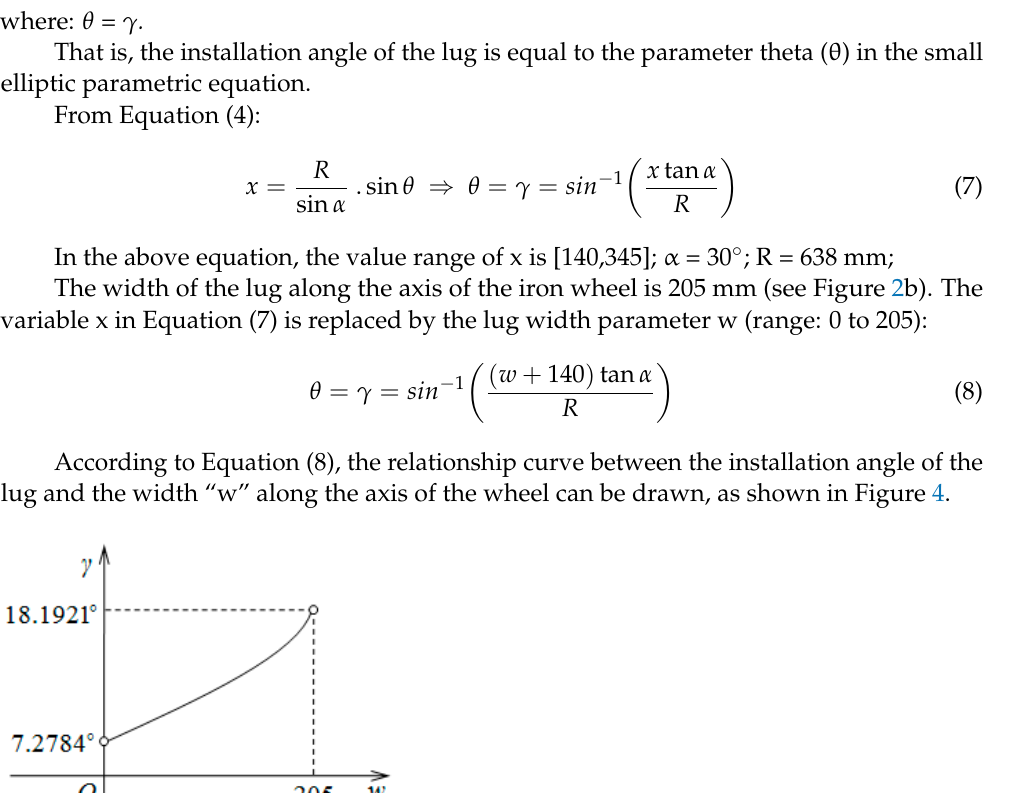
Figure 3. Schematic explanation diagram of working faceplate mounting angle (a) Design model, (b) Prototype “labeling is explained in paragraphs where cited”.